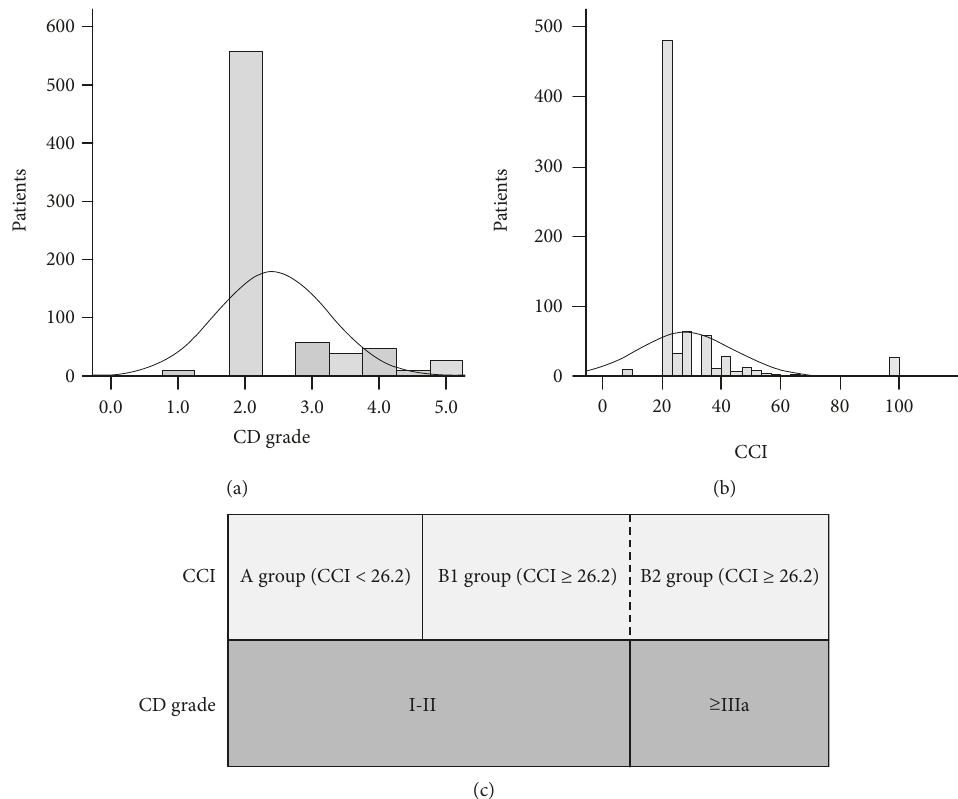
Figure 1: Distribution of complication patients by C-D classi fi cation and CCI, respectively. (a) Histogram with probability density curve (solid line) of CD grade in patients with postoperative complications after curative resection of gastric cancer. (b) Histogram with probability density curve (solid line) of CCI in patients with postoperative complications after curative resection of gastric cancer. (c) Horizontal bar graphs show the di ff erent division by CD grade and